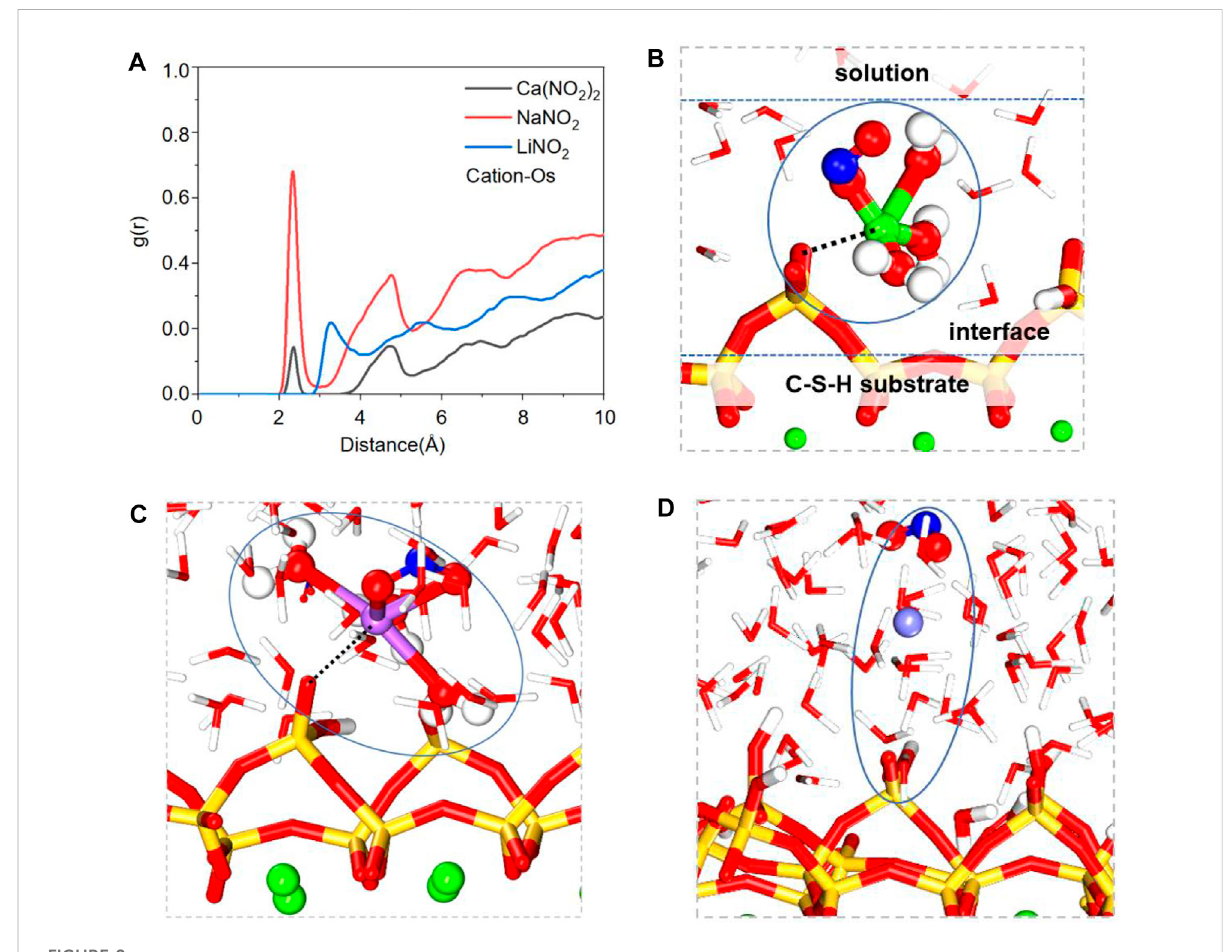
FIGURE 8 (A) The RDF of Cation-O s , the schematic diagram of (B) Ca-O s , (C) Na-O s and (D) Li-O s